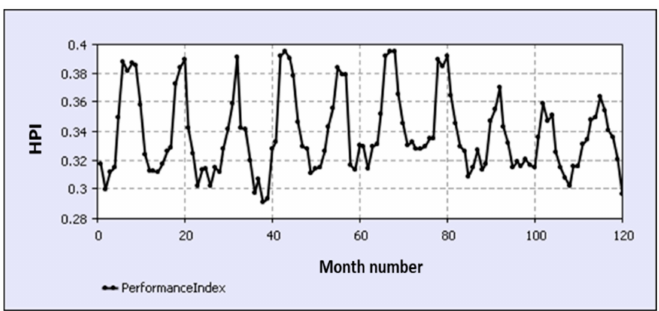
Figure 10. Variation of Hydraulic Performance Index (HPI) over the operation period (2007–2016).